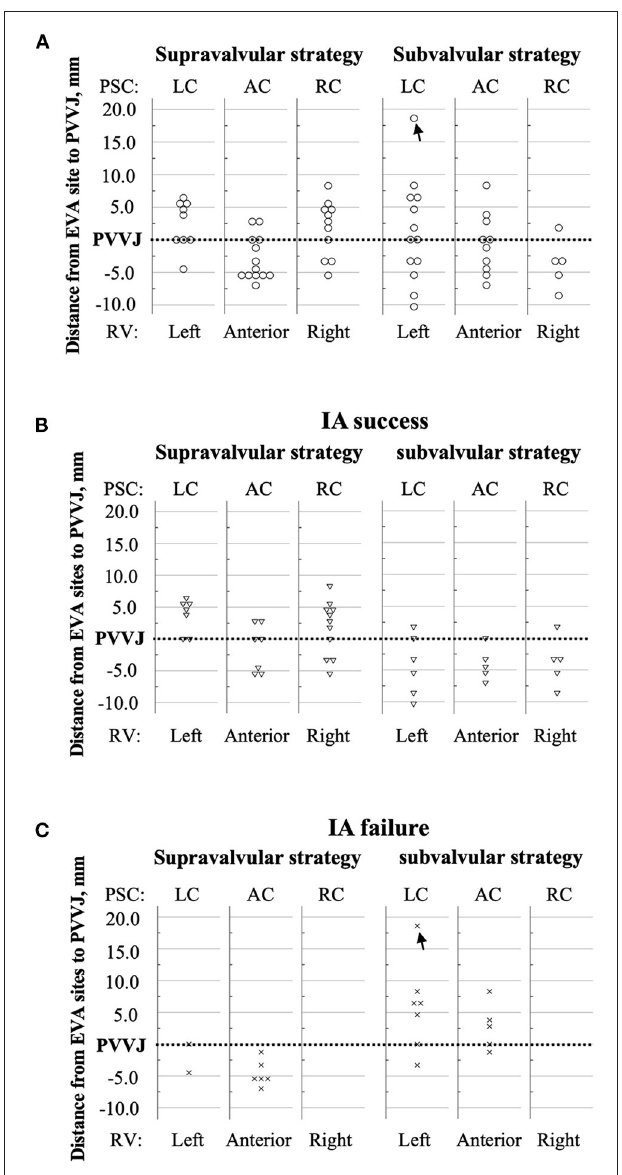
FIGURE 4 | Distances from the EVA sites to the PVVJ. The RVOT was arbitrarily divided by STJ, PVVJ, and longitudinal extensions of PSC commissures. The dotted line denotes PVVJ. The markers that coincided with the PVVJ located at the base of PSCs. The y -axis represents the distance from each EVA site to PVVJ. (A) Circles denote the EVA sites in total patients. (B) The triangles denote the EVA sites in the patients who had IA success. (C) The crosses denote the EVA sites in the patients who had IA failure. The black arrow marks the EVA site in PA. AC, anterior cusp; EVA, earliest ventricular activating; LC, left cusp; PA, pulmonary artery; PSC, pulmonary sinus cusp; PVVJ, pulmonary valve–ventricle junction; RC, right cusp; RV, right ventricle; RVOT, right ventricular outflow tract; STJ, sinotubular